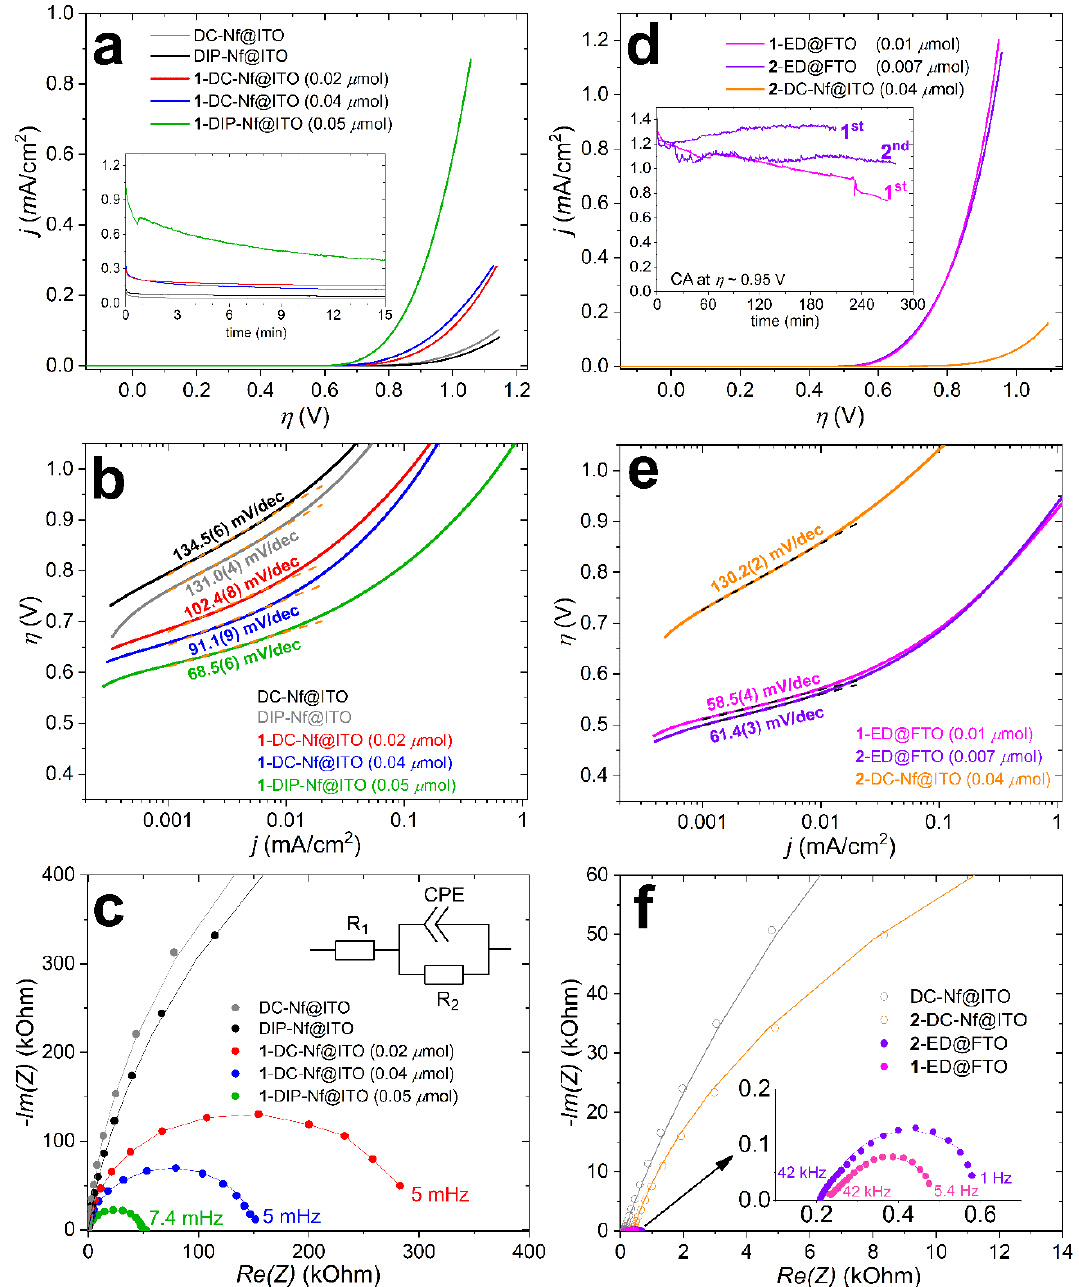
Figure 4. ( a ) LSVs ( ν = 5 mV/s) and inset: chronoamperometry (CA) currents at +1.5 V vs . AgCl/Ag, ( b ) Tafel plot constructed from LSV, and ( c ) Nyquist plot of EIS data (symbols, frequency range from 200 kHz to as indicated) and fitted equivalent circuits (lines) for complex 1 immobilized by the DC and DIP methods (Figure 1) on ITO, and data for the complex-free electrodes for comparison. Inset in ( c ): equivalent circuit for the fitting of the experimental impedance data, R 1 corresponds to the solution + electrode ohmic resistance, R 2 is the charge transfer resistance, and CPE is a constant phase element consisting of a pre-exponential factor P and an exponent (inhomogeneity factor) n; ( d ) LSVs of complexes 1 and 2 immobilized by the ED method and compared to complex 2 on ITO immobilized by the DC method. Inset in ( d ): CA for the same samples at +1.5 V vs . AgCl/Ag, 1st and 2nd runs for 2 -ED@FTO show two consecutive tests with the same elec- trode; ( e ) Tafel plots, and ( f ) Nyquist plot of EIS data (symbols) and fitted equivalent circuits (lines) for the same samples as those in ( e ). Conditions: all measurements were done in 0.2 M borate buffer at pH 8.2, Pt auxiliary and AgCl/Ag refer- ence electrodes (more details in experimental section).